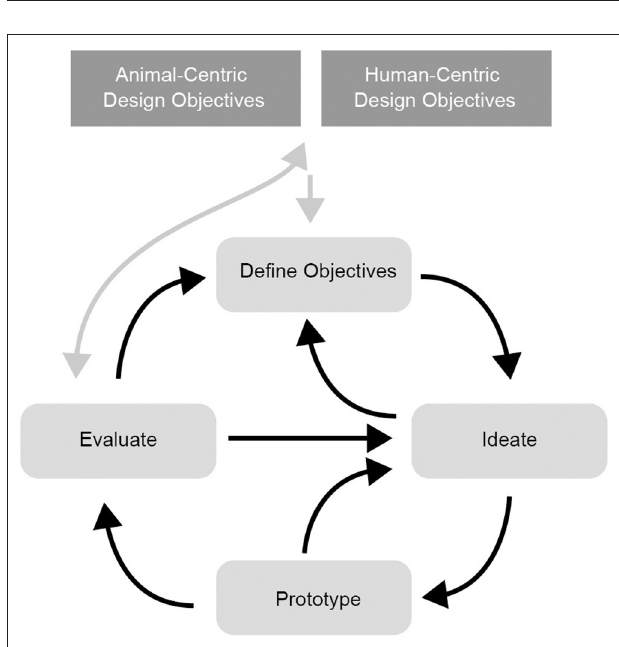
FIGURE 3 | The welfare through competence interaction design process.